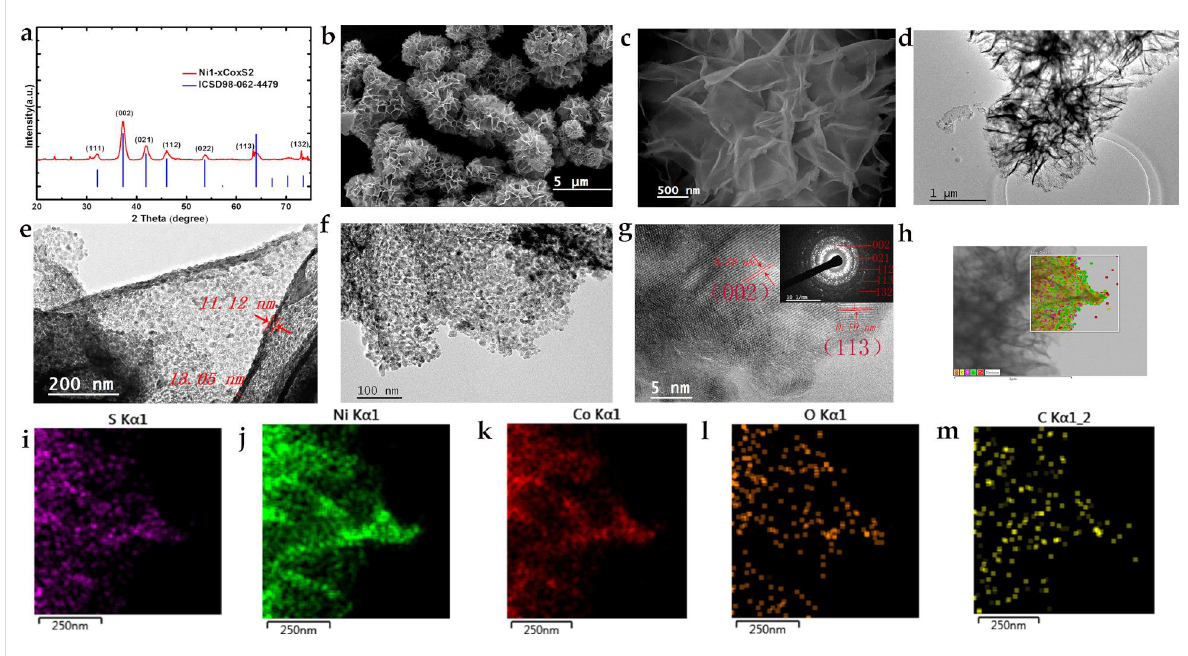
Figure 1: (a) X-ray diffraction patterns of Ni 1 − x Co x S 2 ; (b) FESEM images and (c) enlarged FESEM images of Ni 1 − x Co x S 2 nanoparticles; (d–g) TEM, HRTEM and SAED pattern (inset) of the Ni 1 − x Co x S 2 nanoflakes; (i–m) EDS elements maps of S, Ni, Co, O and C from the image (h).